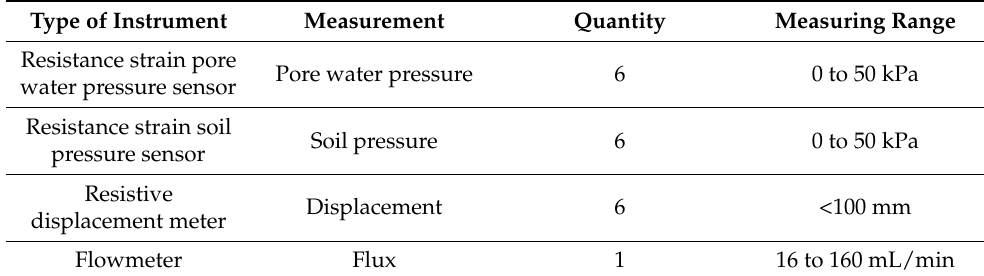
Figure 7. Construction of the physical simulation models: ( a ) Slide bed; ( b ) Slide surface; ( c ) Slide mass; ( d ) Entire model.